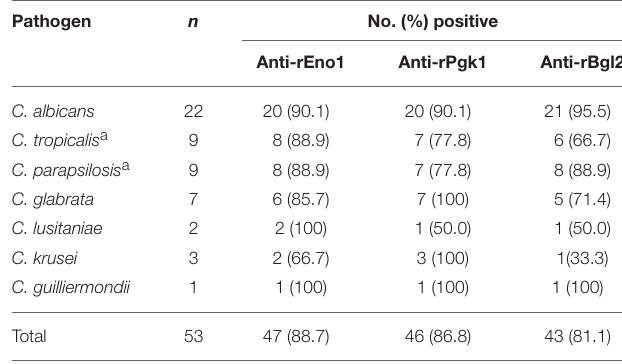
TABLE 3 | Sensitivity, specificity, and predictive values for the detection of anti-rEno1, anti-rPgk1 and anti-rBgl2 a . Cutoff Sensitivity, specificity, PPV b , NPV c ,